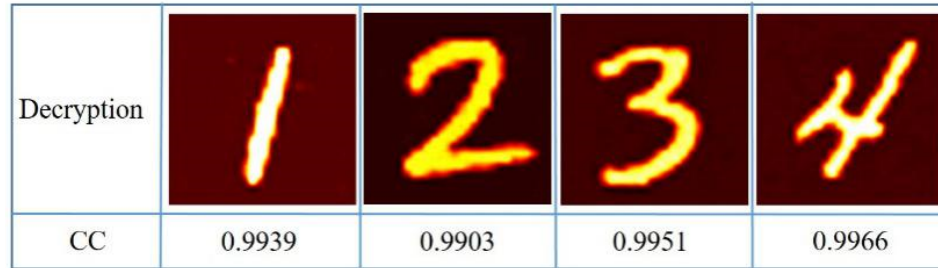
Figure 6. The first set of decryption results.